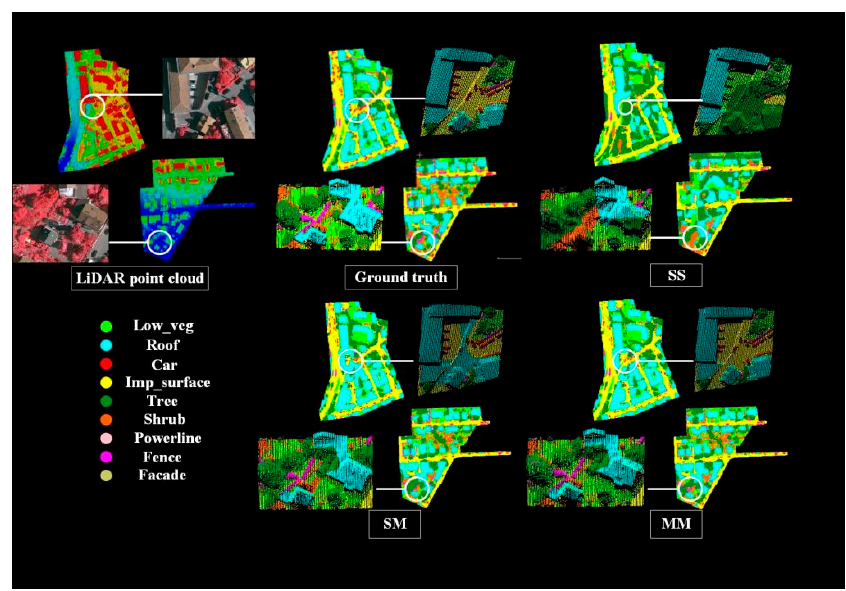
Figure 5. All kinds of ground features and overall classification accuracy.